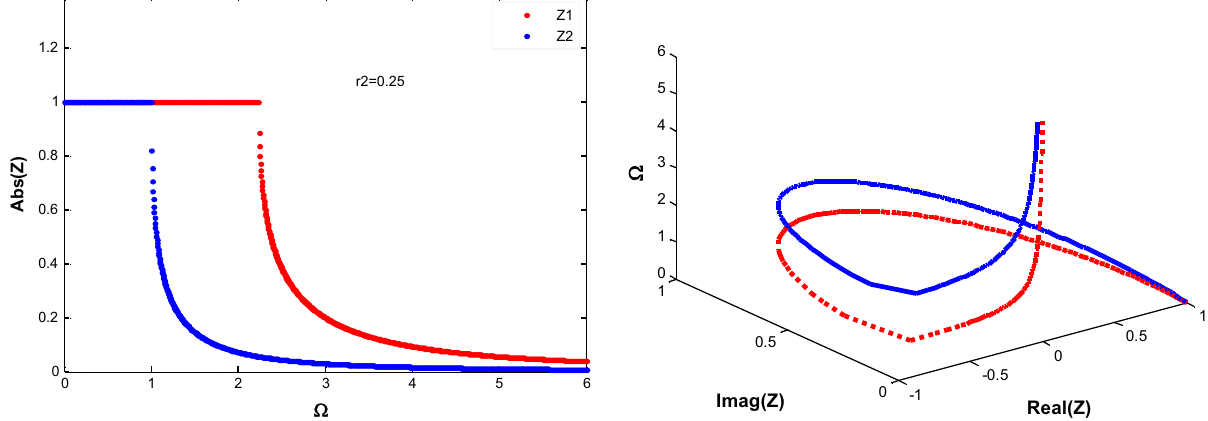
Figure 2: Absoluteof phase factor Z as function, r 2 and dimension - less frequency Ω .